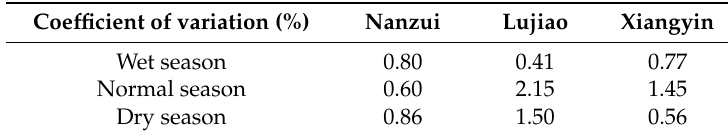
2004/12/3 2004/12/10 2004/12/17 2004/12/24 Figure 4. Comparisons of time series of water elevation between predictions and measurement during the dry season. ( a ) the Nanzui station; ( b ) the Lujiao station; ( c ) the Xiangyin station. Table 1. The values of Cv calculated at the selected stations in the Dongting Lake area during different time periods.